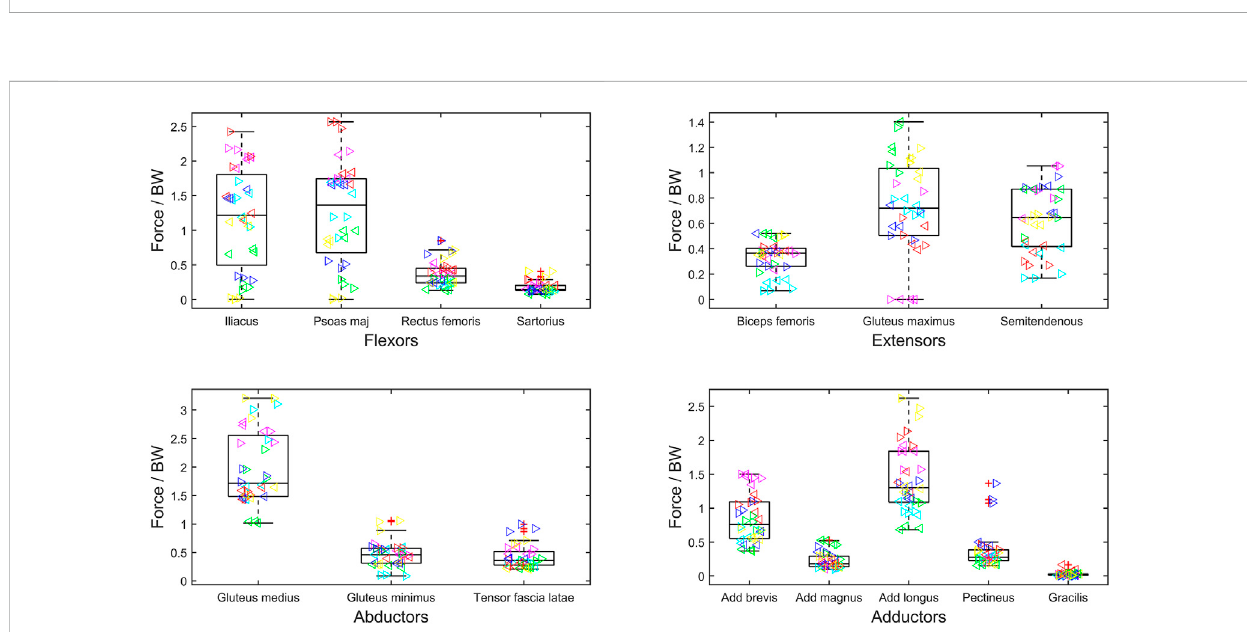
FIGURE 3 Maximummuscleforcenormalizedtobodyweight(BW)duringgaitcycleofbilateraltransfemoralpersonswithlimbloss.Musclesarecategorizedas hip fl exors,extensors,abductors,andadductors.Theboxplotsshowmin,max,median,25and75percentiles,andtheoutliers.Eachsubjectisplottedina separate color, and the left legs are represented by ‘ ► ’ and right by ‘ ► ’